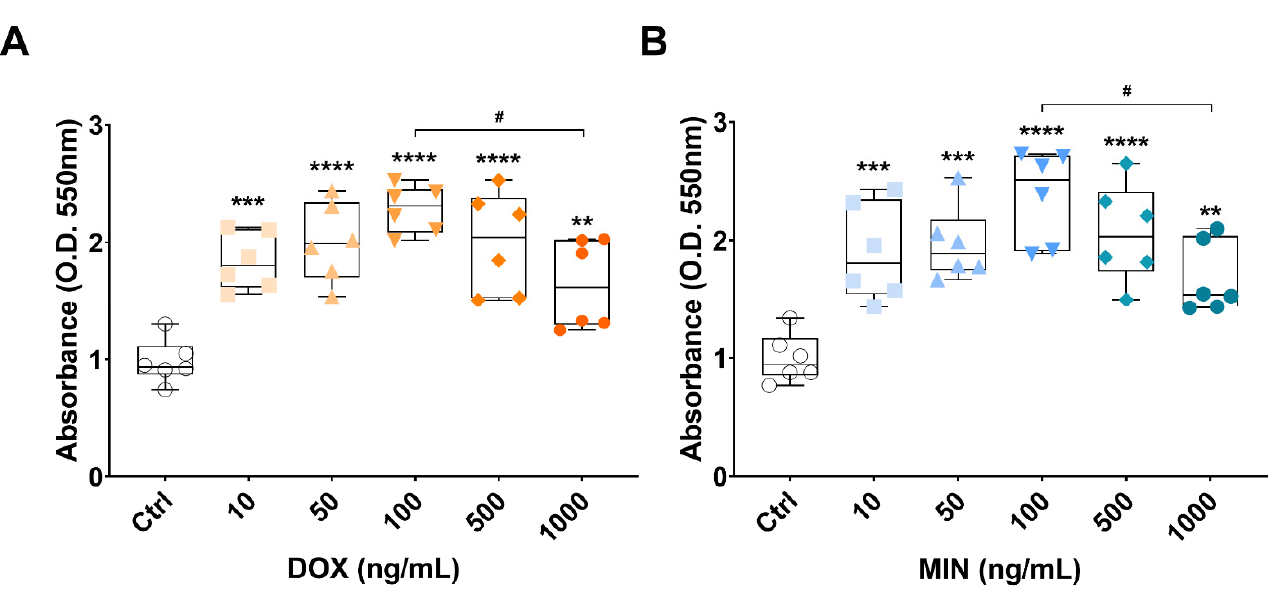
Figure 2. Cell viability of RT4 cells exposed to increasing concentrations of doxycycline or minocycline. Analysis of cell viability (MTT assay). RT4 cells were grown under normal conditions and exposed to increasing concentrations (0, 50, 100, 500 or 1000 ng/mL) of ( A ) doxycycline or ( B ) minocycline for 24 h. Values are reported as mean optical densities (OD) ± S.E.M. from two experiments, each using five batches of cells. ** p < 0.01, *** p < 0.001 or **** p < 0.0001 vs. Ctrl; # p < 0.05 vs. 100 ng/mL DOX ( A ) or MIN ( B ), as determined by ANOVA followed by Tukey’s post-hoc test.